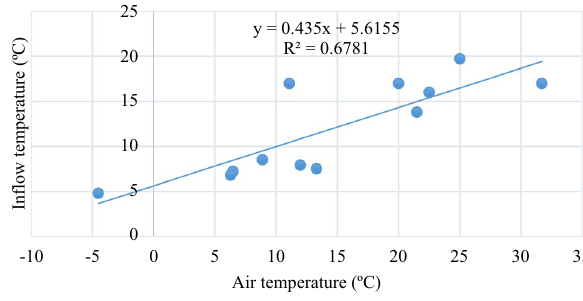
Fig. 3 The air temperature in Nir synoptic station versus inflow tem- perature